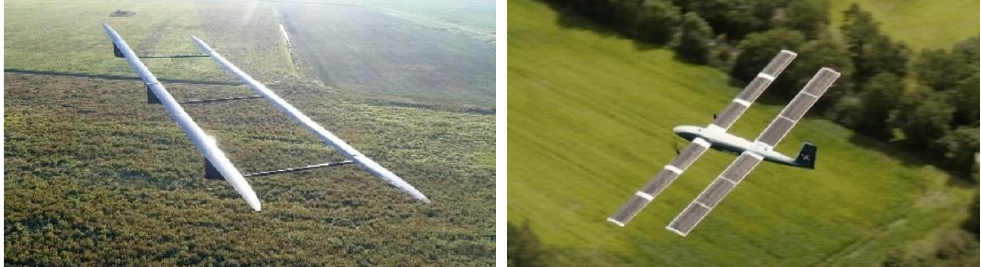
Figure 2 . ApusDuo by UAVOS ( left ) and SolarXOne by XSun ( right ) tandem-wing prototypes. Figure 2. ApusDuo by UAVOS ( left ) and SolarXOne by XSun ( right ) tandem-wing